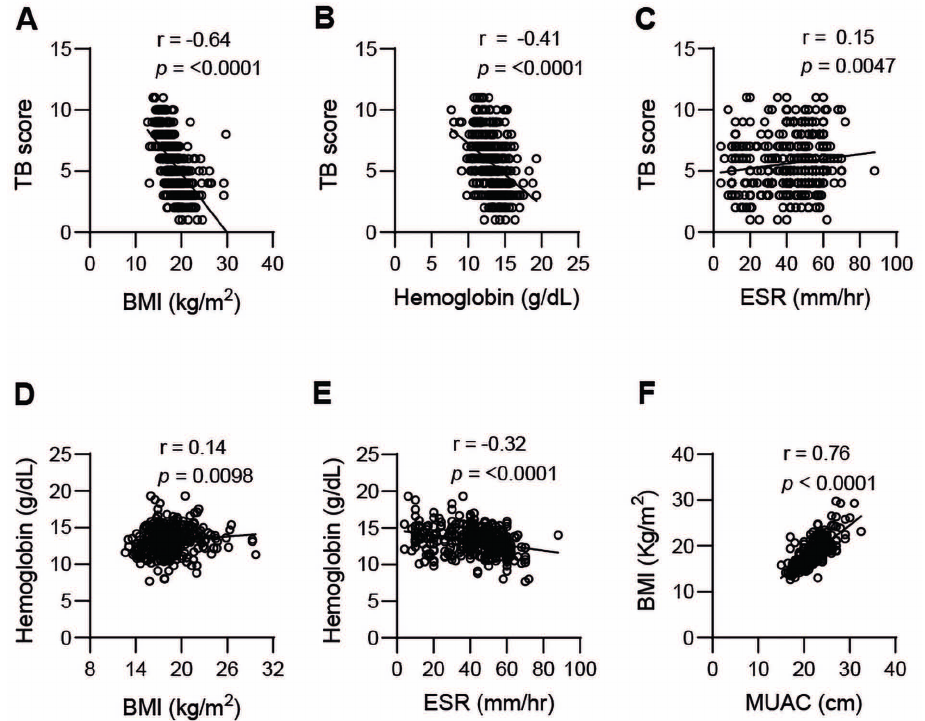
Figure 2. Correlation analyses between the clinical TB score and ( A ) BMI, ( B ) blood Hb, and ( C ) ESR, or blood Hb and ( D ) BMI, or ( E ) ESR. There was a strong correlation between BMI and MUAC ( F ). Correlation was determined using Spearman ´ s correlation